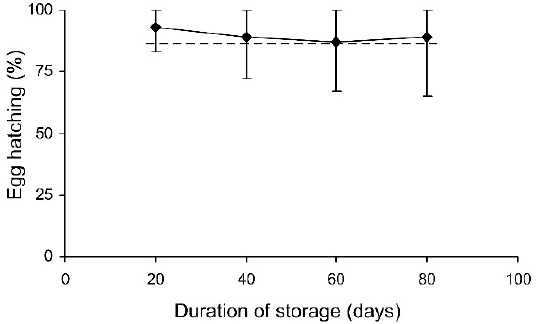
Figure 6. The percentage of hatched eggs of Cheilomenes propinqua females in relation to the temper- ature (the results of the short-term experiment). Medians and quartiles are shown. The dashed line shows hatching in the controls.